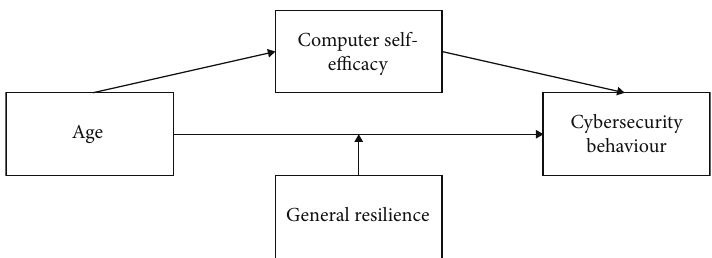
Figure 2: Model testing mediation via computer self-e ffi cacy and moderation via general resilience (PROCESS model 5).